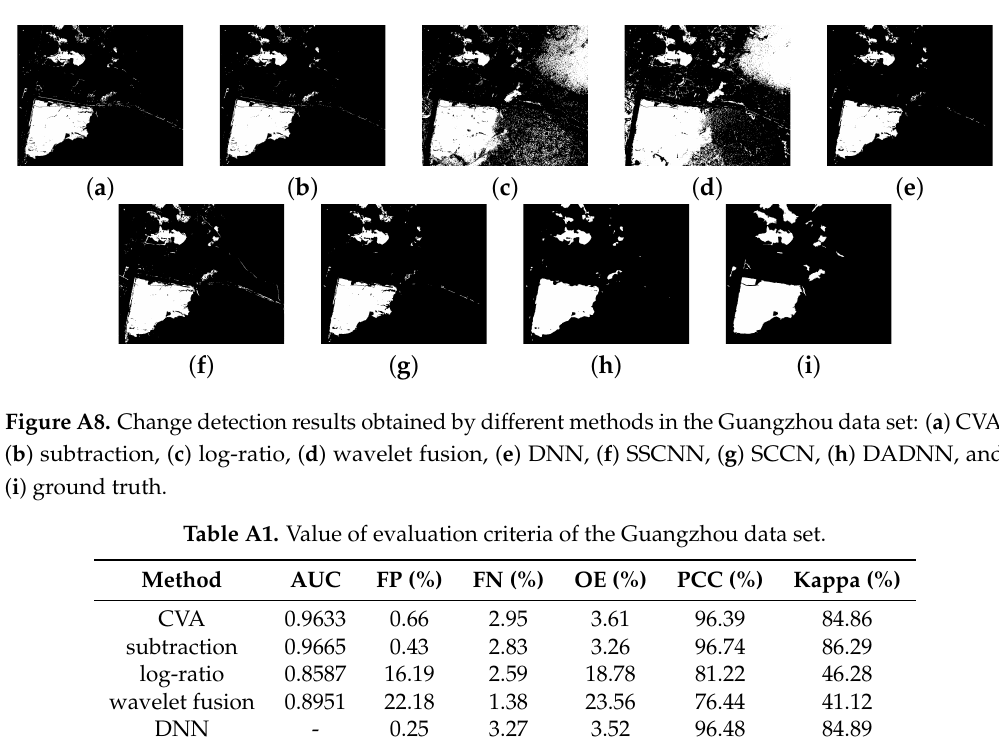
Figure A7. The ROC plots of the six difference maps on the Guangzhou data set. The right shows corresponding enlarged areas of red boxes in the left.